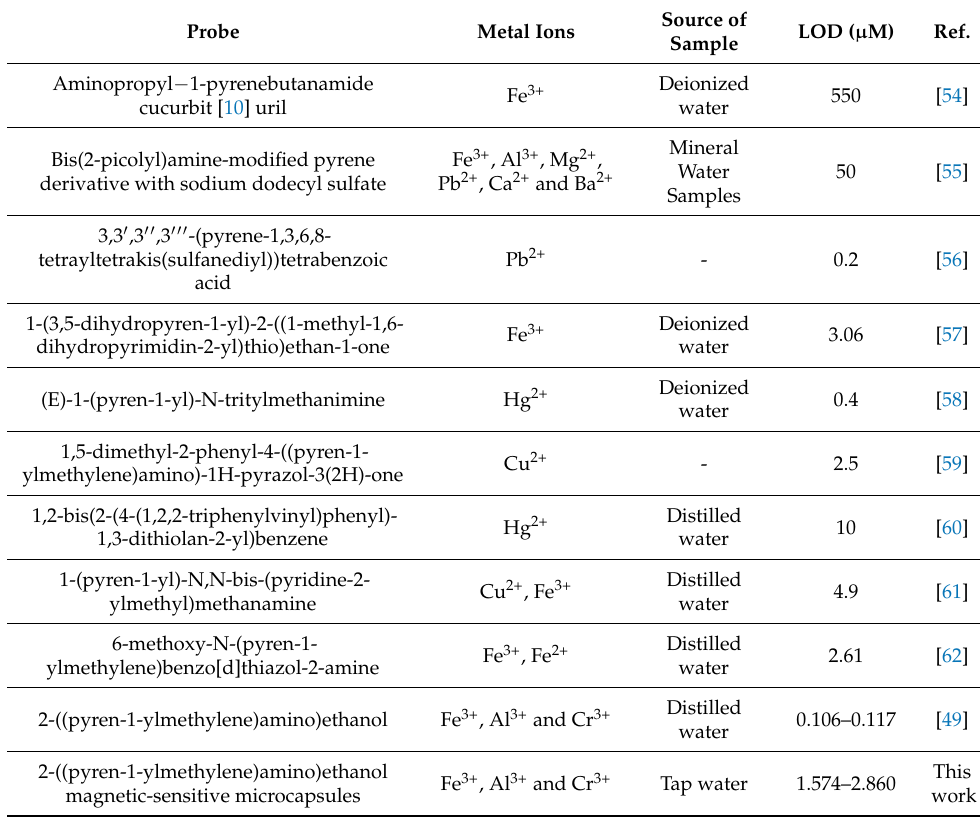
Table 1. Comparison of previous reported pyrene-based derivative sensors for metal ions detection.